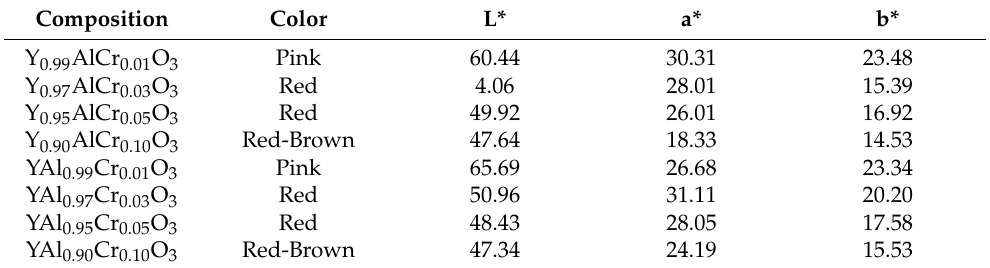
Table 2. Chromatic coordinates values of glazed tiles in the Y 1 − x Cr x AlO 3 and YCr x Al 1 − x O 3 systems. Composition